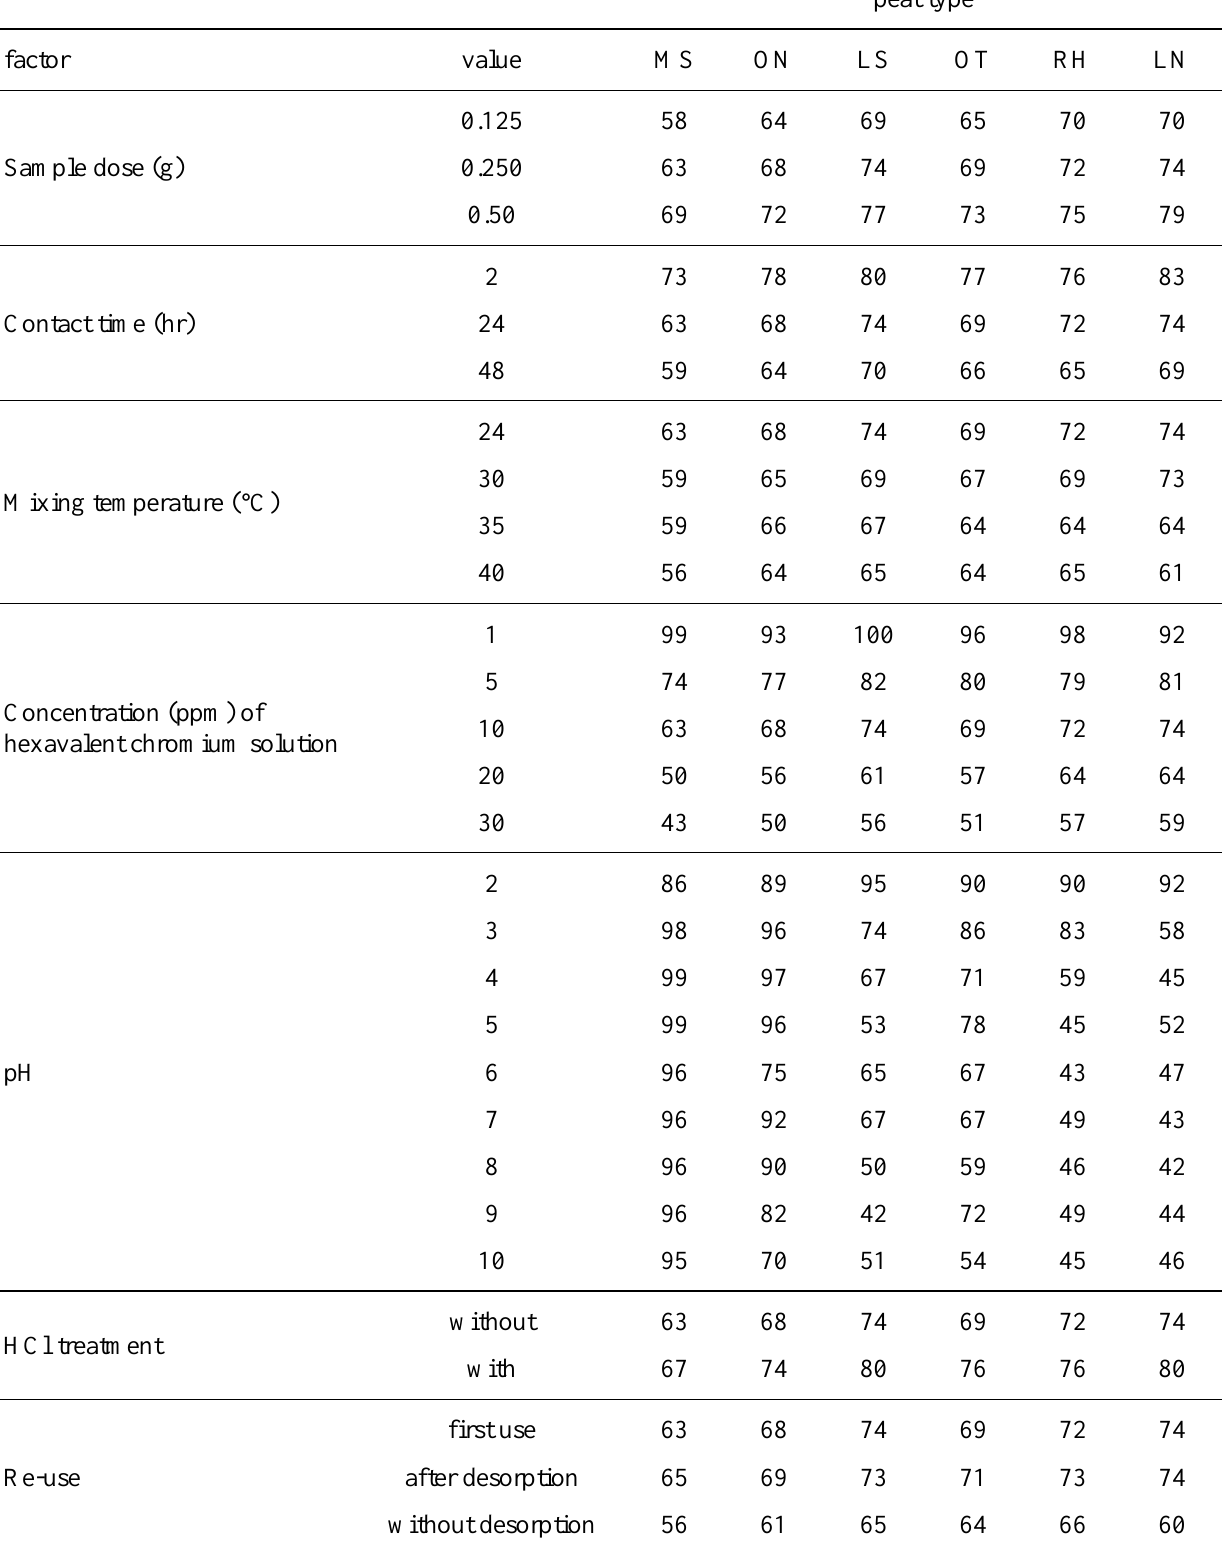
Table 2. Percent hexavalent chromium biosorption by each of the six peat types with variation of the factors that were